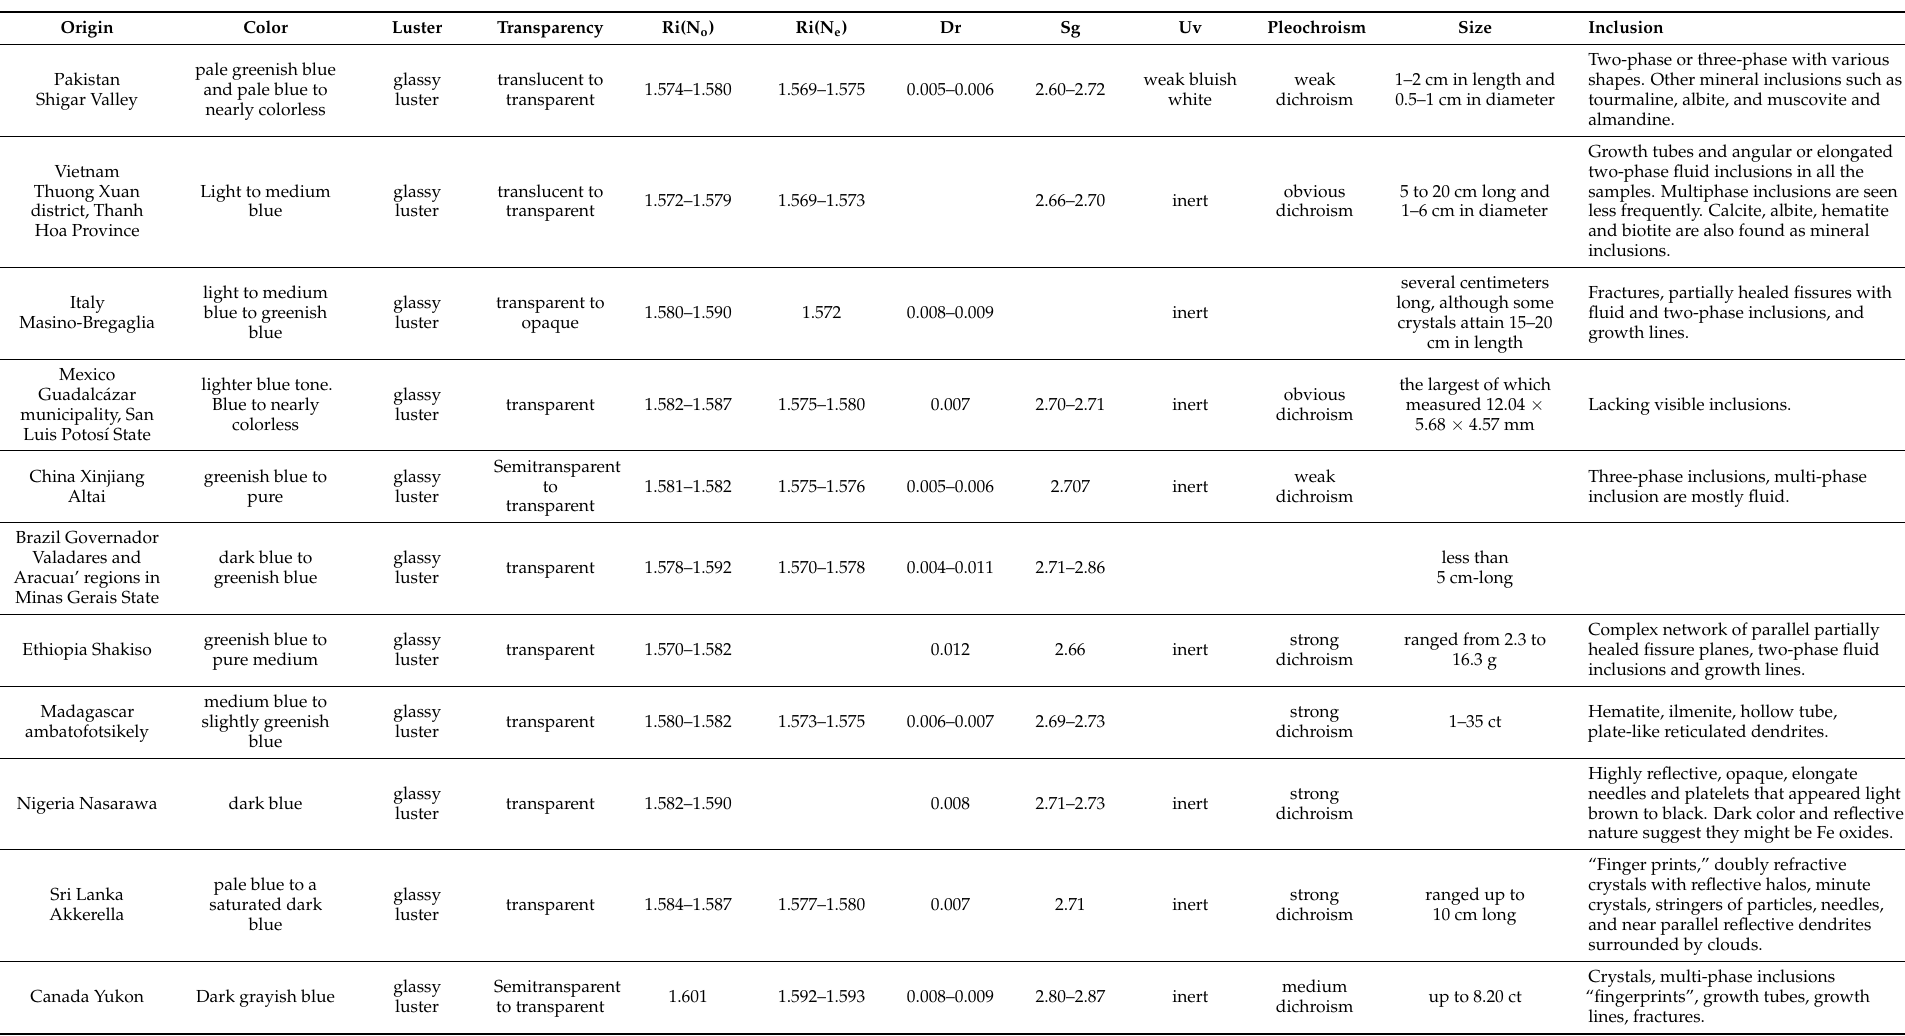
Table A3. Characteristics of aquamarine from different producing